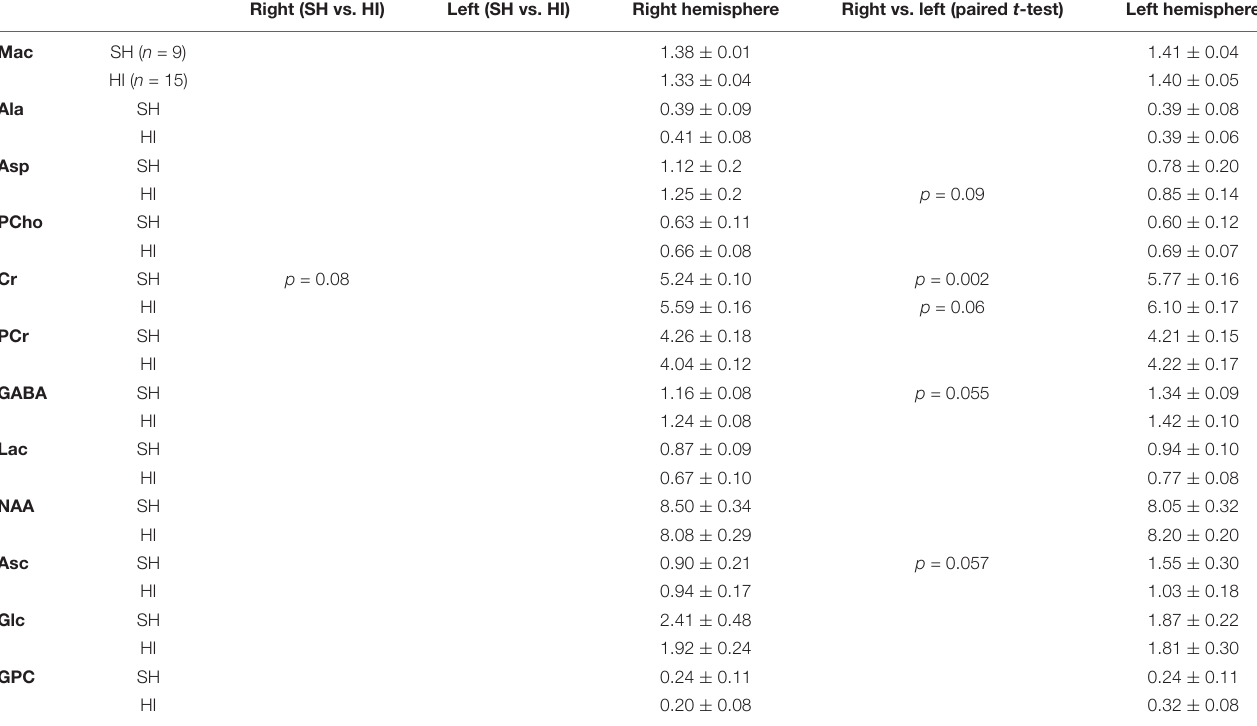
TABLE 2 | Summary of additional cerebellar metabolic results obtained from localized 1 H-MRS. Right (SH vs. HI) Left (SH vs. HI) Right hemisphere Right vs. left (paired t